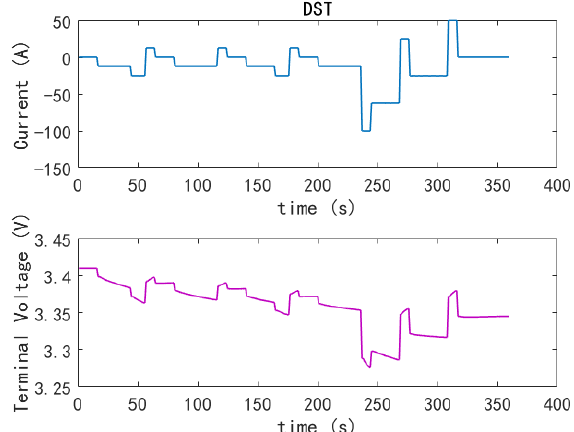
Figure 5. Voltage and current of a DST cycle.